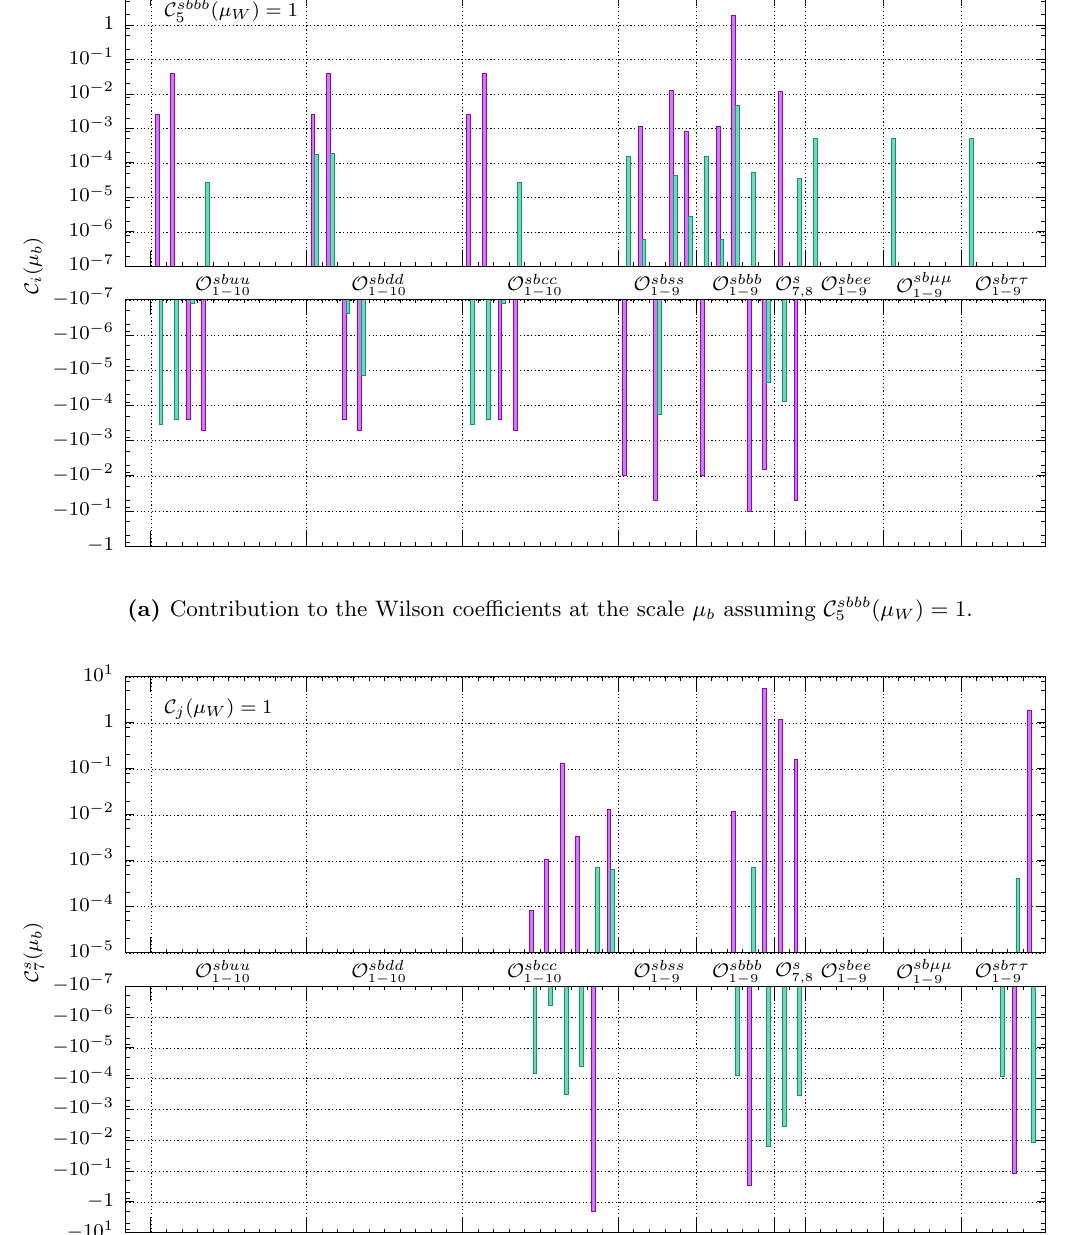
Figure 2. Examples of spectra of Class V. Purple and green bars correspond the QCD and QED renormalization-group evolution given by the matrices ^ U s and (cid:1) ^ U e , respectively.